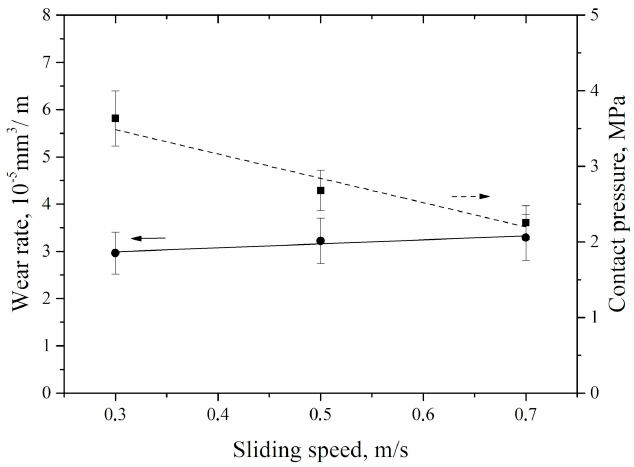
Figure 9. UHMWPE wear rate vs. sliding speed.